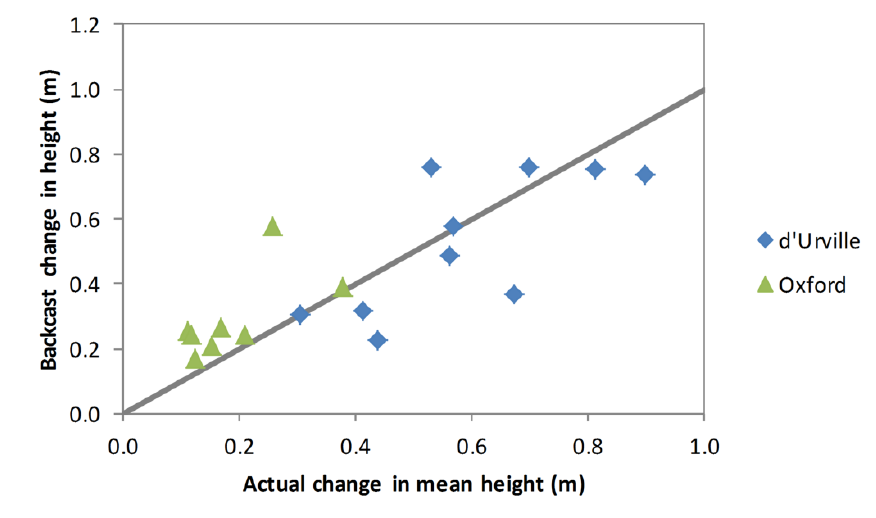
Figure 7. Backcast estimated 2008–2012 change in height versus actual change in height for plants measured for diameter and height in both 2008 and 2012. Values shown are plot means. The line indicates the y = x